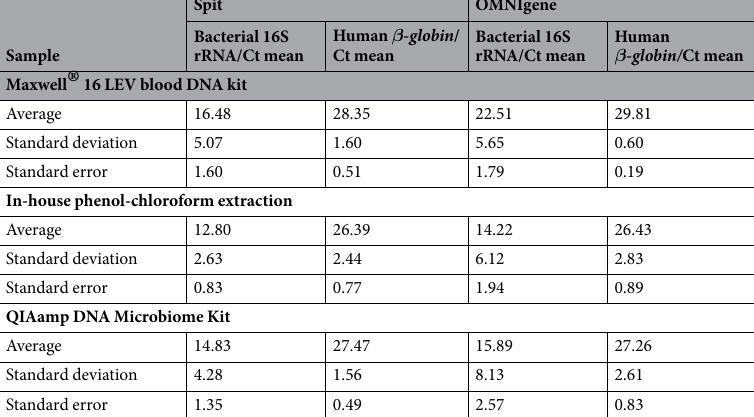
The taxonomic profiles of spit, drool and oral rinse samples were examined based on the proportion of bacte- rial sequences determined at genus level (Supplementary Data 5). The five major genera found in all three saliva